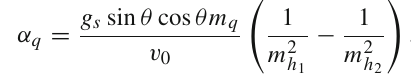
with the matrix elements m p , n f q = u , d , s and f